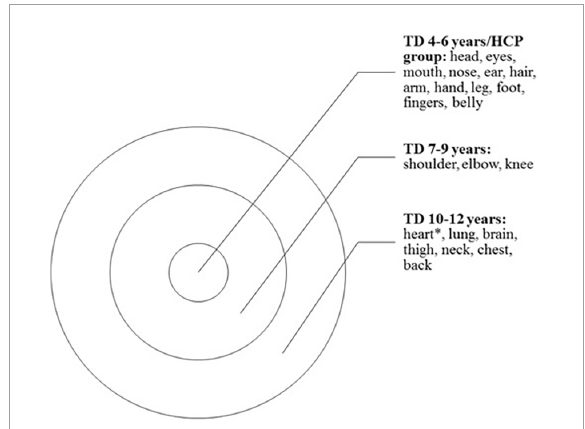
FIGURE2 Illustration representing the semantic network core obtained from networks, representing the words quoted more frequently for each category. All groups presented a common central core. TD 4–6 years, Typically developing children group (4–6 years old); TD 7–9 years, Typically developing children group (7–9 years old); TD 10–12 years, Typically developing children group (10–12 years old); HCP group, hemiplegic cerebral palsy group; ∗ heart was also cited by HCP